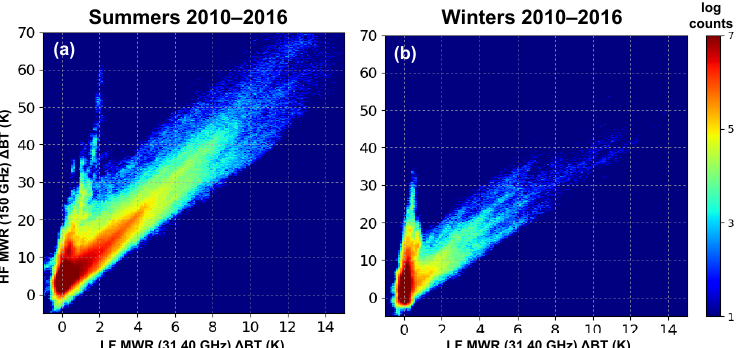
Figure 3. These are the MWR observations minus the clear-sky contribution, for all available data during precipitation events from 2010 to 2015. The summer precipitation is shown in (a) (summer is defined as May through September), and the winter precipitation is shown in (b) (winter is defined as October through April). The summer MWR observations indicate both IC and CLW snow events occur through the season, though there are more CLW events. The winter season tends to strongly favor the IC snow